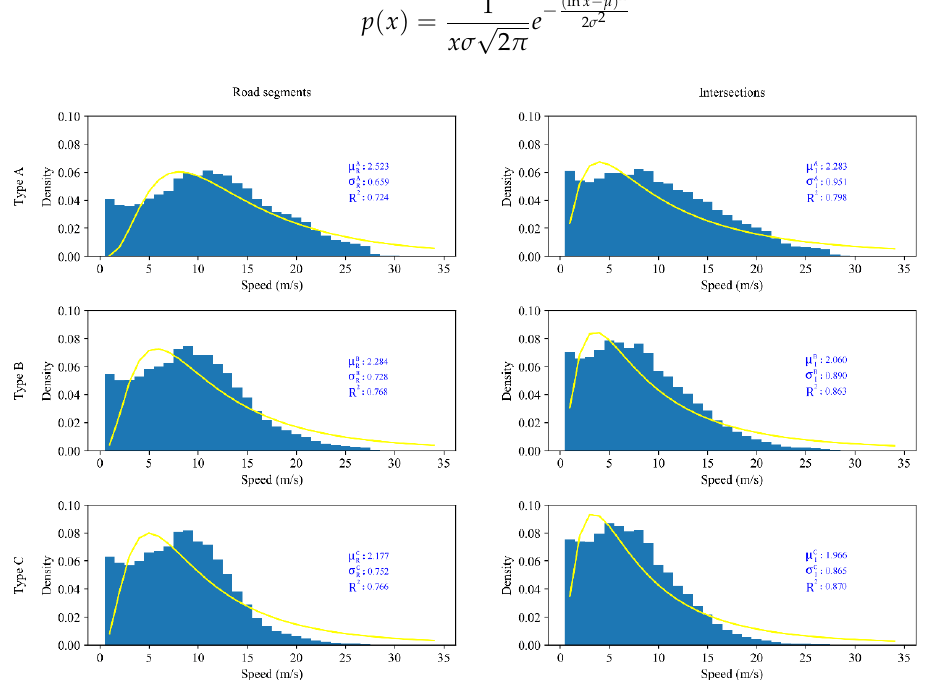
Figure 8. Speed distributions for different types of drivers in different driving environments. A high value of R 2 (ranging from 0 to 1) represents a good fitting model. The results show that the R 2 values of the six fittings are all greater than 0.7, which indicates that the lognormal model could represent more than 70% of the features of the